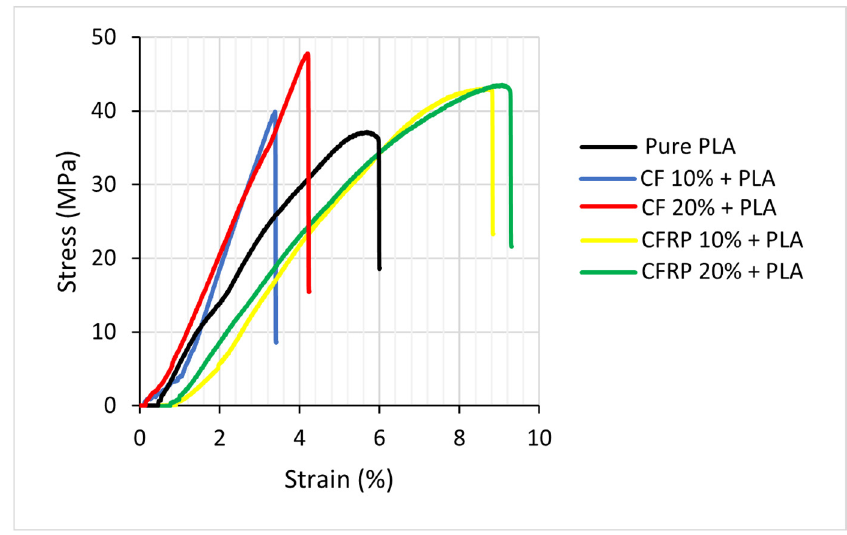
Figure 12. Stress-strain curve for the recycled PLA and four recycled composites. Table 2. The mechanical properties of the recycled Carbon/PLA composites with standard deviation (SD).